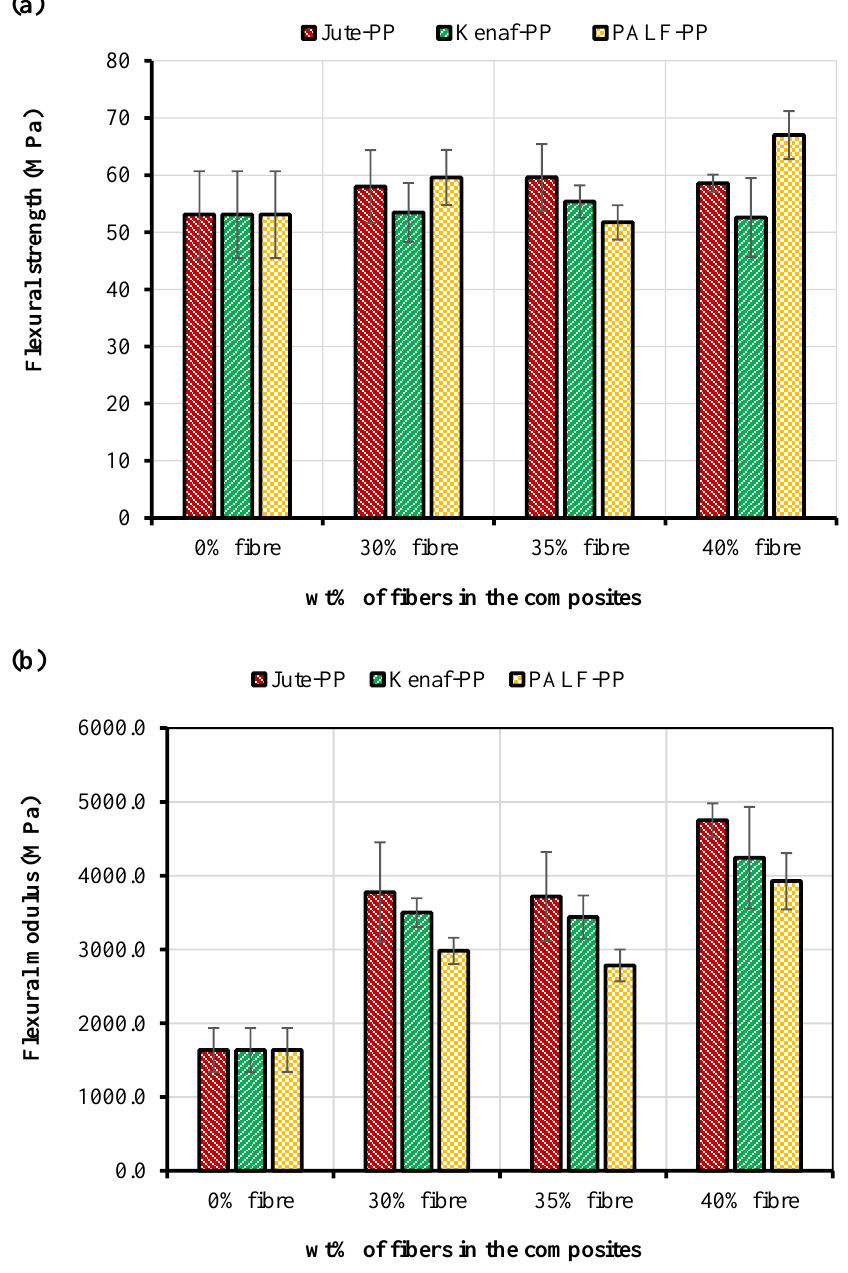
Figure 8. ( a ) Flexural strengths and ( b ) modulus of jute, kenaf, and PALF fiber-reinforced PP composite specimens.